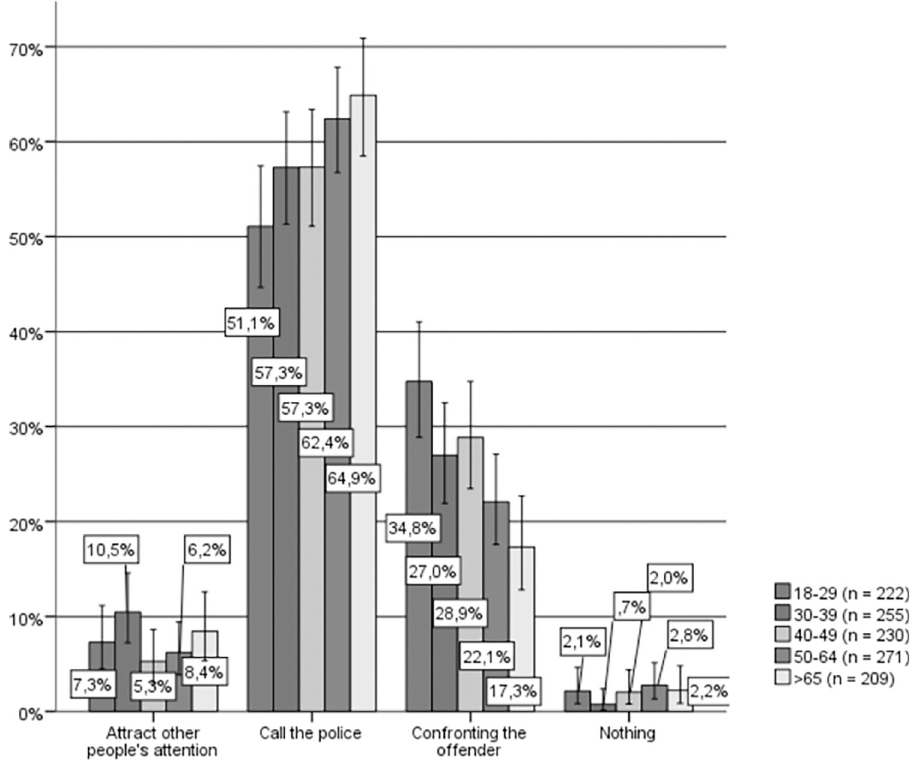
Fig 4. Hypothetical response to IPVAW, men by age group. Source: Own elaboration based on CIS study 2968 [43] question 14. 95% confidence intervals are provided for each subsample.